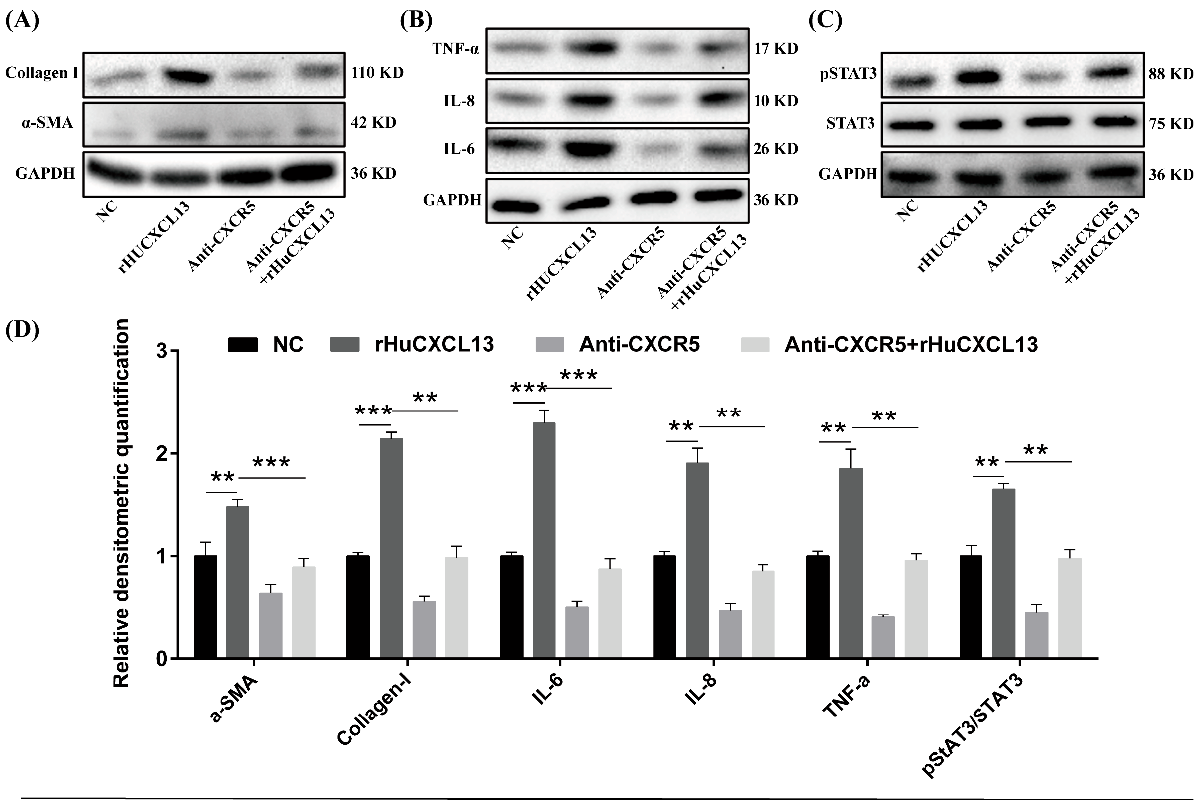
Figure 6. Anti-CXCR5 (1 μ g/mL) could rescue the alternations induced by rHuCXCL13 in WPMY-1 cells. ( A – C ) Western blot assay of fibrosis-, inflammation-, and pathway-related proteins. ( D ) Relative densitometric quantification of fibrosis-, inflammation-, and pathway-related proteins. ** p < 0.01 and *** p < 0.001.